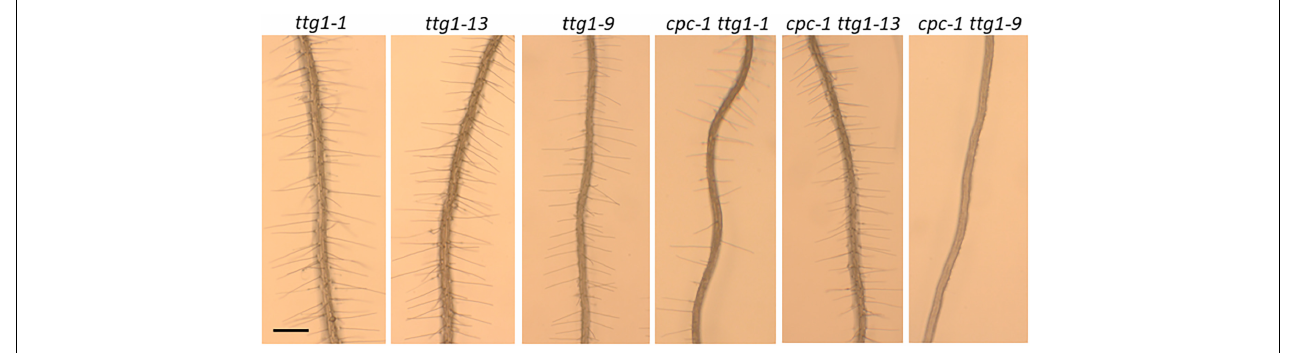
FIGURE 5 | Seedling roots of ttg1-1 , ttg1-13 , ttg1-9 , cpc-1 ttg1-1 , cpc-1 ttg1-13 , and cpc-1 ttg1-9 displaying their root hair phenotypes. Bar = 200 µ